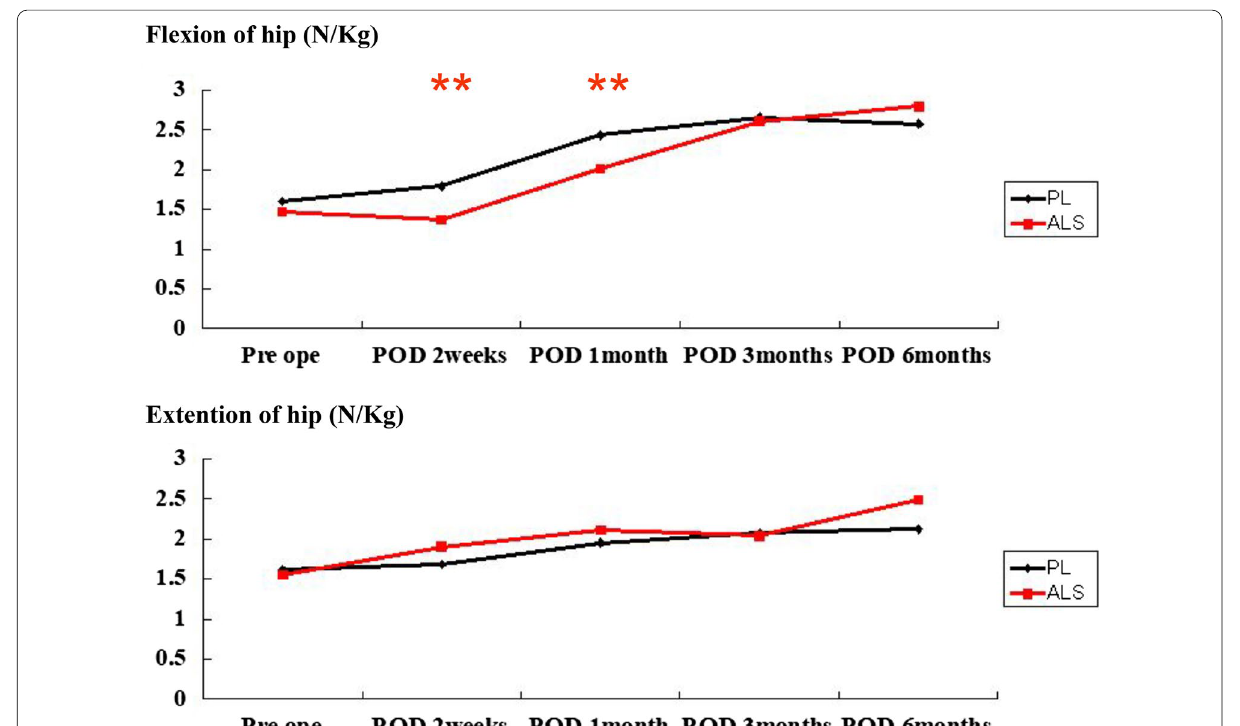
Fig. 1 Evaluation of muscle strength of hip flexion and extension. Hip flexion was significantly weaker in the ALS group than in the PL group until 1 month after operation. ALS: anterolateral supine; PL: posterolateral; POD: postoperative day. **Indicates significance at P <